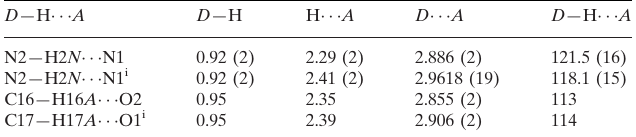
Hydrogen-bond geometry (A˚ , (cid:2)